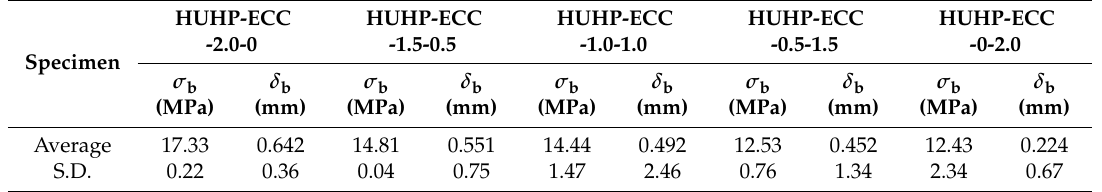
Table 6. Results of single-crack tension tests.